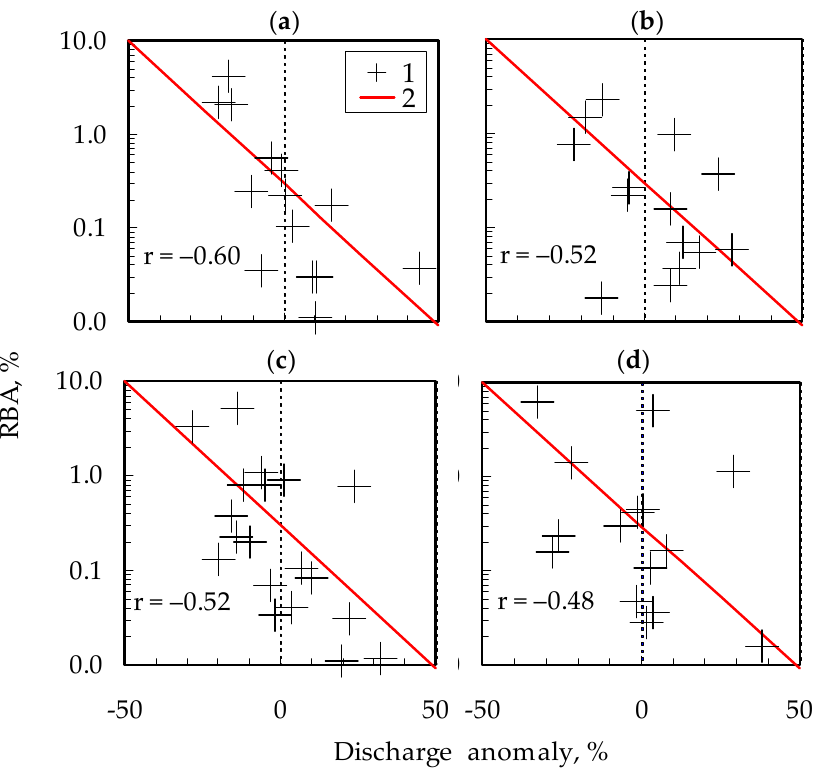
Figure 4. RBA ( γ , %) vs. the discharge anomalies for the first half of the vegetation season (March–July). ( a ) Podkamennaya Tunguska, ( b ) Lower Tunguska, ( c ) Aldan, and ( d ) Viluy. 1—data, and 2—linear model.